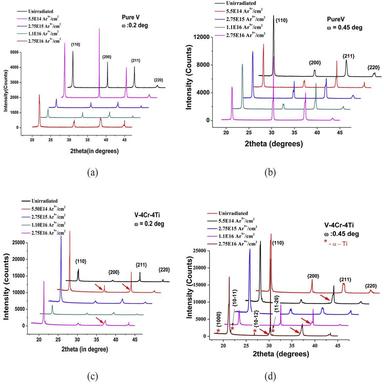
XRD pattern of one as received sample and four irradiated samples of pure V (a) and (b) and V-4Cr-4Ti (c) and (d) (obtained at incident angle of 0.2 deg and 0.45°) The extra peaks in the highest dose sample of V-4Cr-4Ti have been identified as α-Ti.